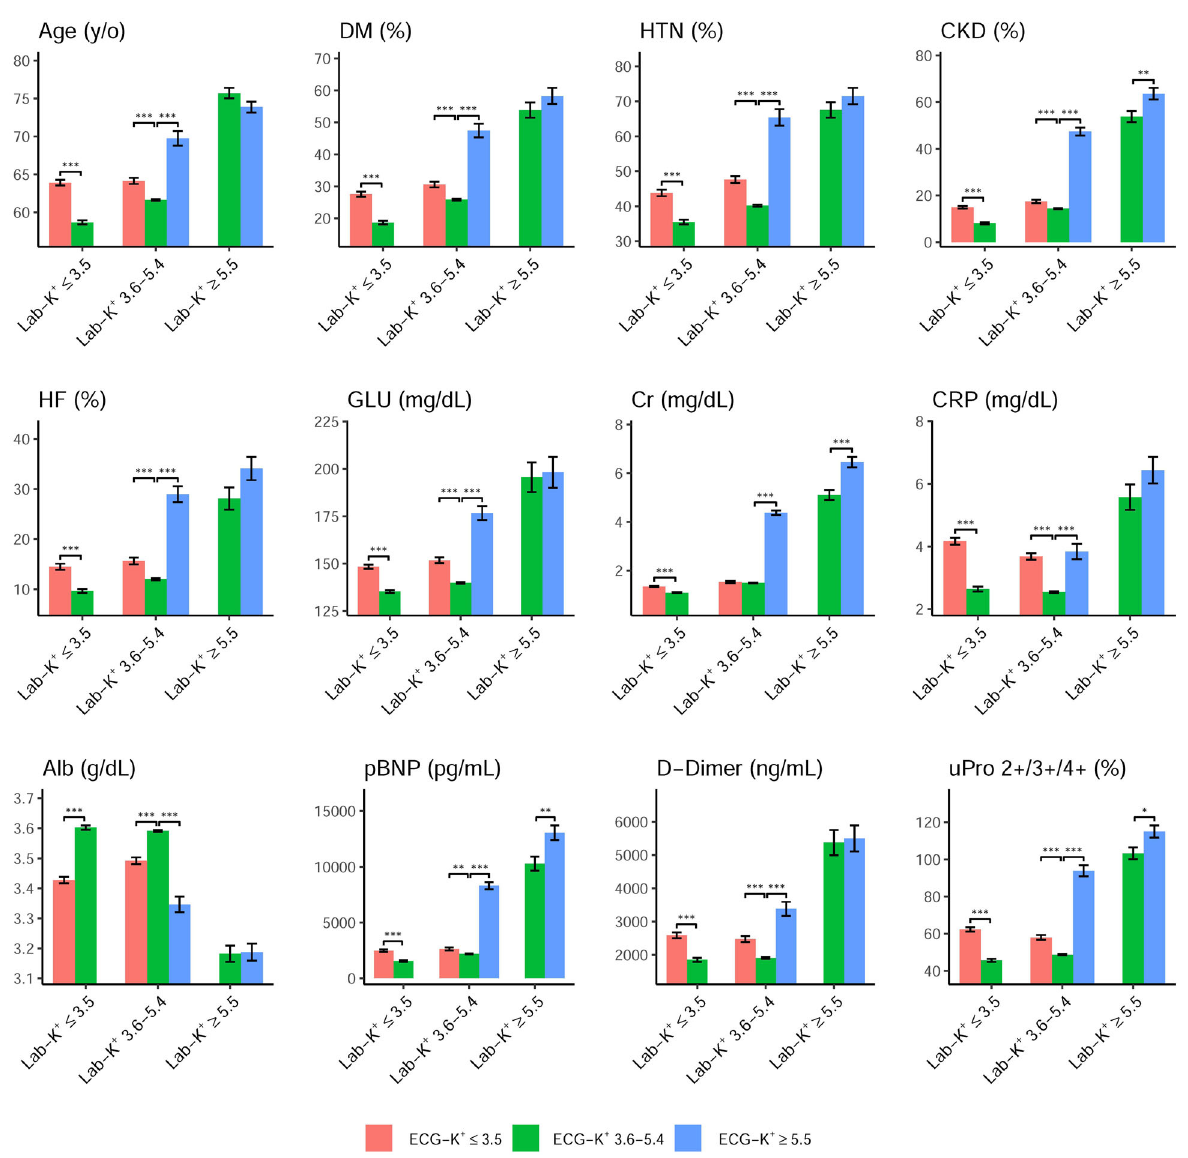
Fig. 5 Selected patients ’ characteristics in different ECG-K + and Lab-K + groups. Bars represent the mean or proportion where appropriate and corresponding 95% conference intervals, which are adjusted by hospital and Lab-K + via linear or logistic regression (* p < 0.05; ** p < 0.01; *** p <